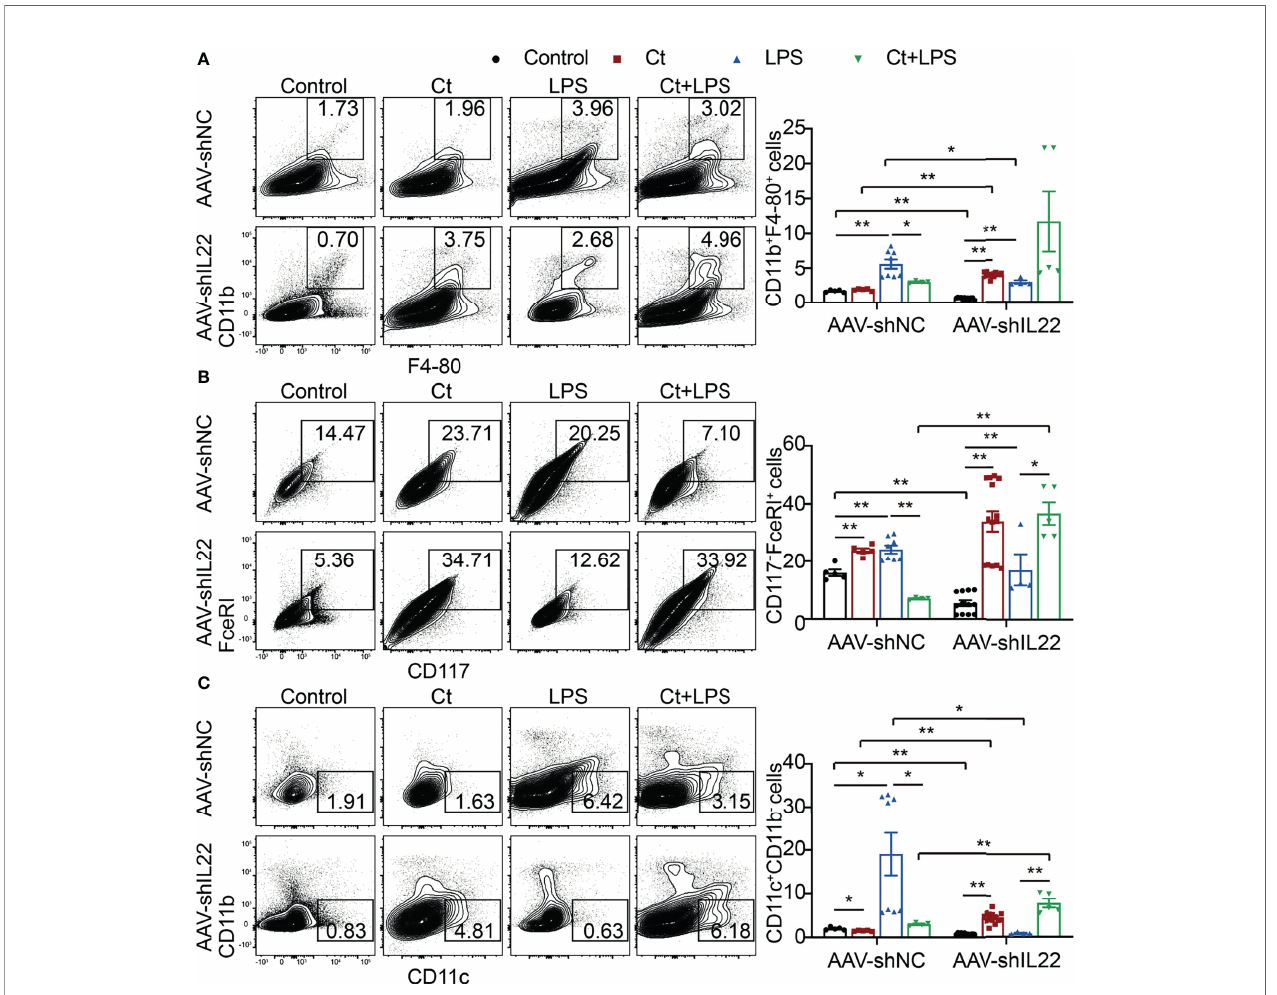
FIGURE 4 | Effects of Ct on the proportions of macrophages, mast cells, and DCs in the ileum. Flow cytometric analyses were conducted on 8-colour FACS Verse and three panels were used to analyzing the intestinal immune cells. The single cells were fi rst gated on SSC-A vs FSC-A and FSC-A vs FSC-H, and then CD45 + FVS780 - cells (CD45 + Live + cells) were gated out. CD11b + F4-80 + cells, CD117 + FceRI + cells, and CD11c + CD11b - cells were gated out from CD45 + Live +